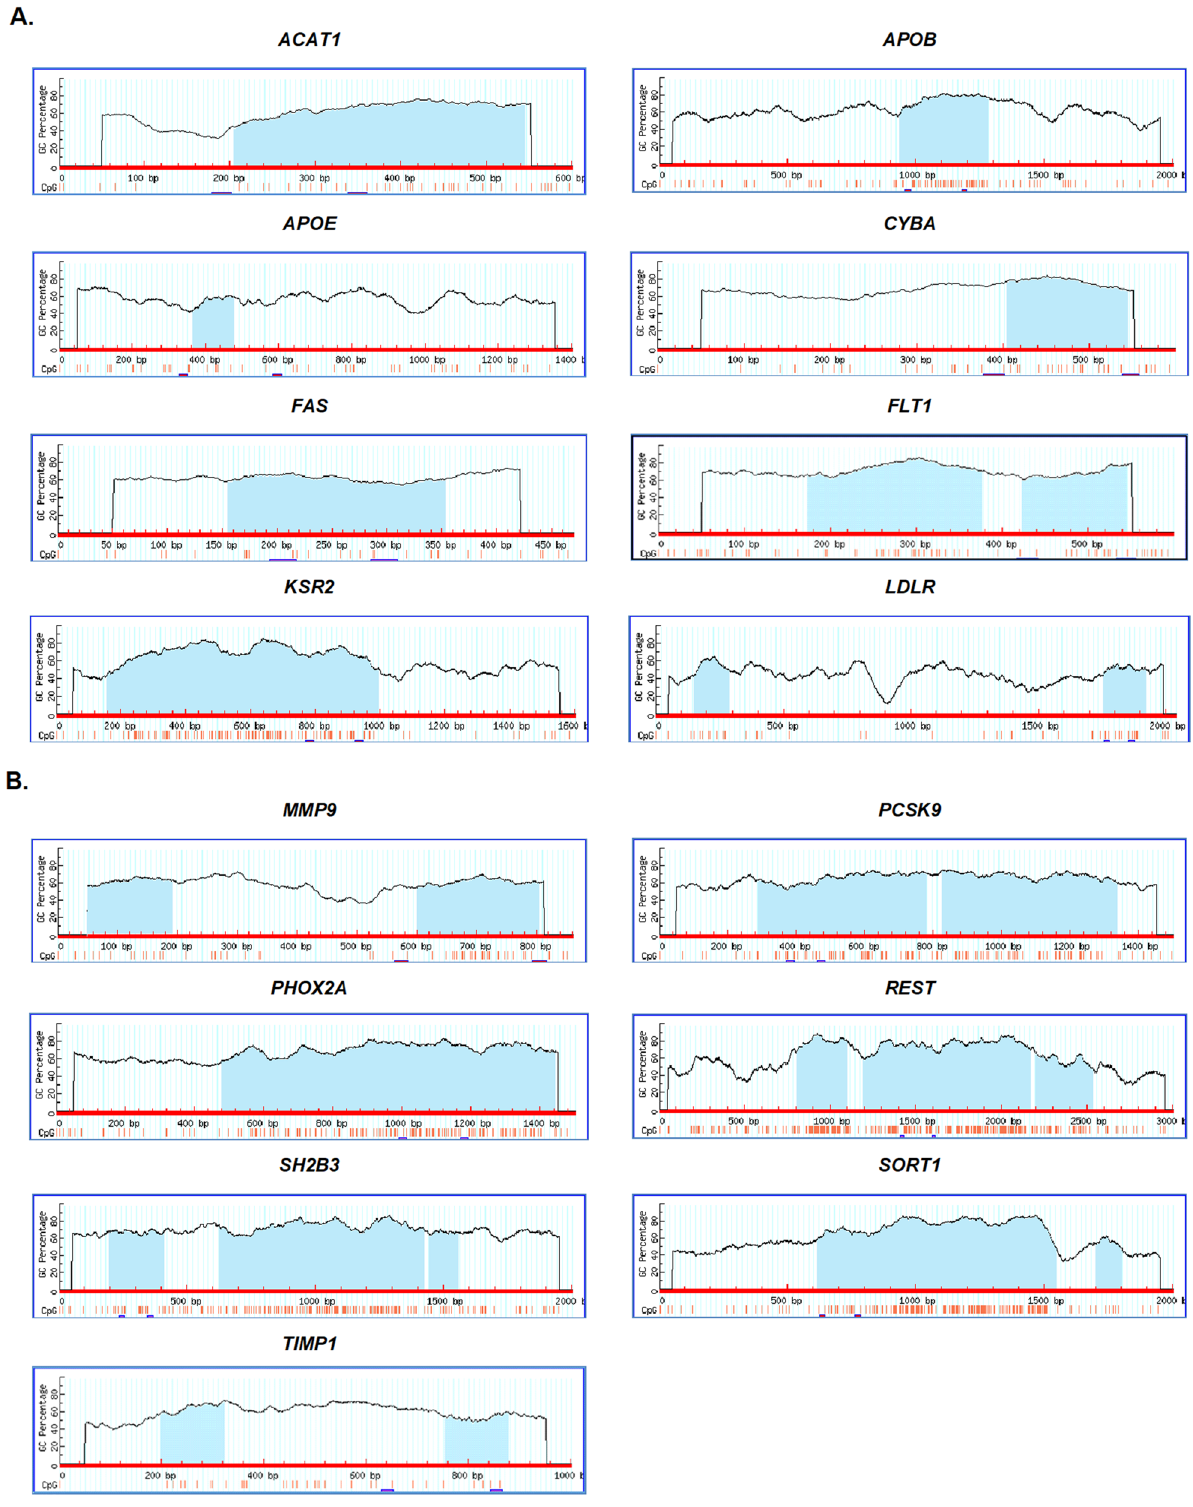
Figure 2. CpG islands prediction in promoter sequence of genes. ( A ) ACAT1 , APOB , APOE , CYBA , FAS , FLT1 , KSR2 , LDLR . ( B ) MMP9 , PCSK9 , PHOX2A , REST , SH2B3 , SORT1 , TIMP1 . The figure consists: input sequence to predict the CpG islands and to design bisulfite/ methylation specific PCR primers, CpG island